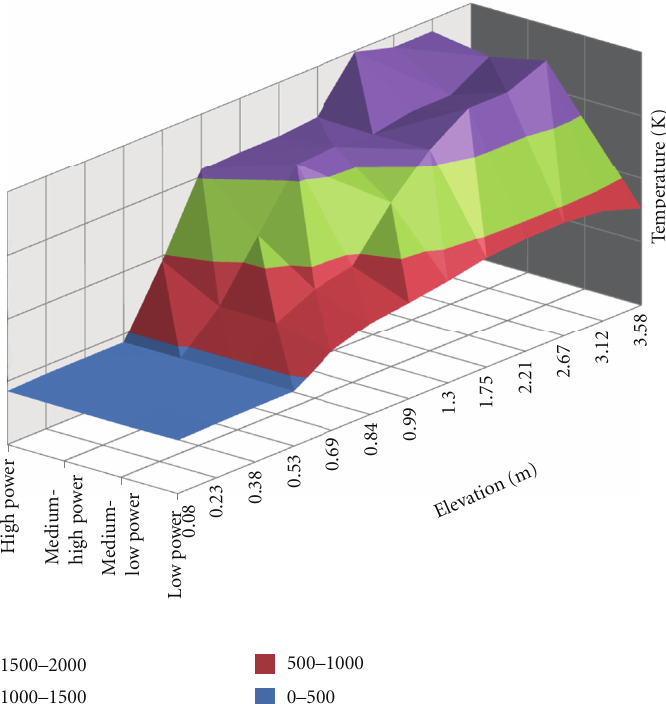
Figure 35: Core temperature distribution at 5.0 hours for scenario with water injection at 4.9 hours after scram (all emergency water injection was terminated at 4.2 hours after reactor scram).